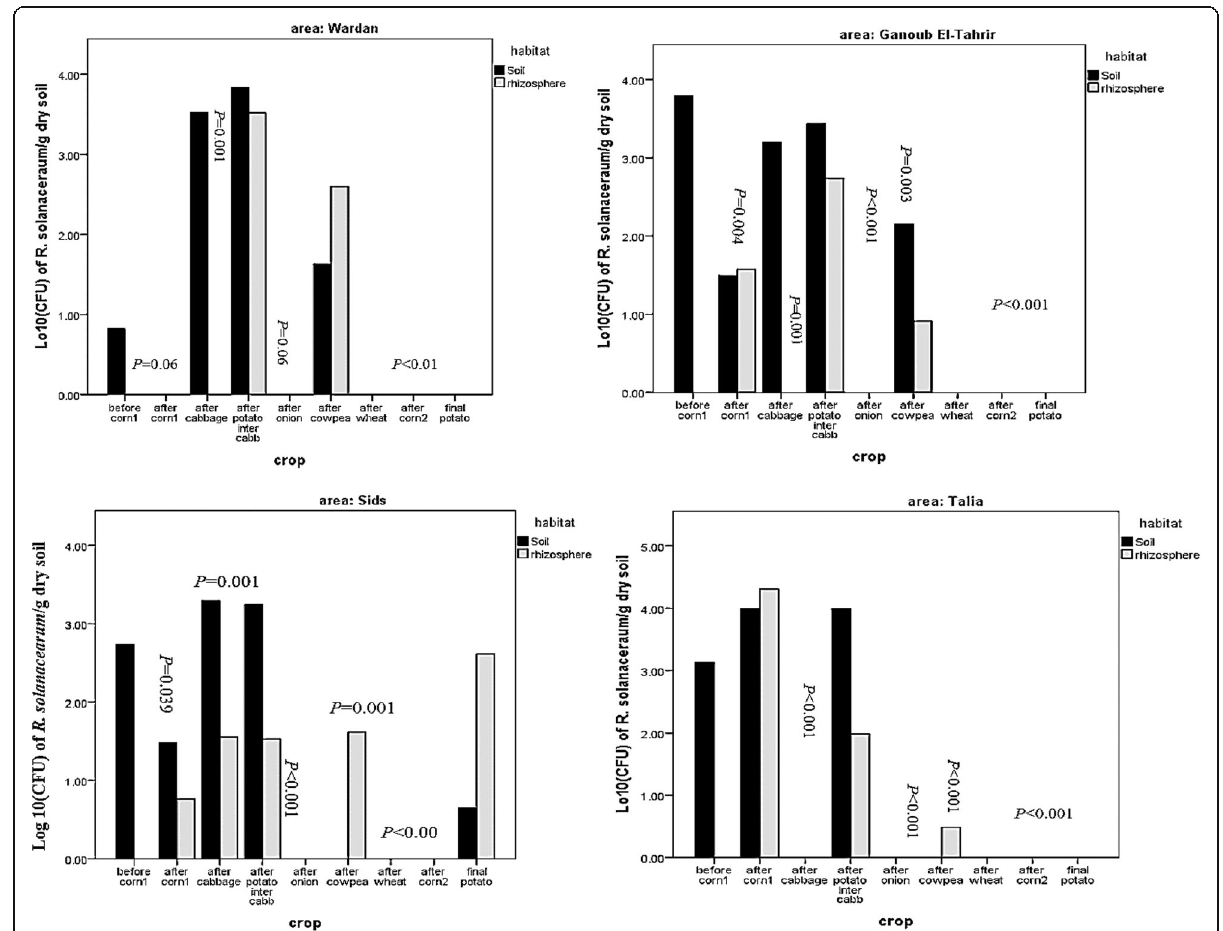
Fig. 2 Density of the pathogen in different soil and rhizosphere (Log CFU + 1) after different crop successions in four districts. District 1 (Wardan): Giza Governorate (sandy soil). District 2 (Ganoub El-Tahrir): Behera Governorate (sandy soil). District 3 (Talia): Minufyia Governorate (clay soil). District 4 (Sids): Bani Suef Governorate (clay